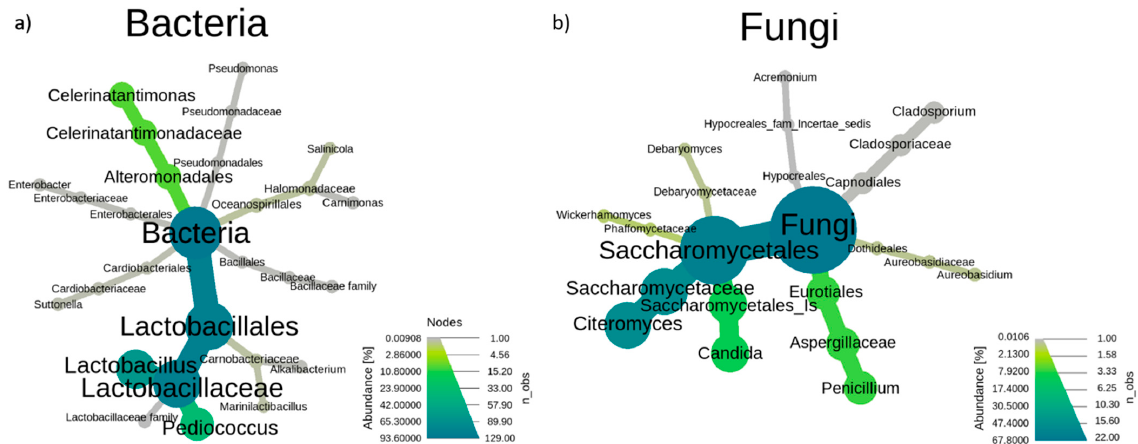
Figure 2. Heat tree from order to genus level obtained by 16 S ( a ) and internal transcribed spacer (ITS) region ( b ) metataxonomic analysis using the total of samples ( n = 15 for bacteria and n = 14 for fungi). Samples that failed quality control ( n = 3) were removed from the study. The colour and size of the branch are indicative of the abundance of sequences (%). Data were generated by grouping all sampling times. Table 1. Global alpha diversity indexes for bacteria (16S) and fungi (ITS) populations obtained from traditional packed Aloreña de M á laga table olives. Data are expressed as a mean ± the standard olive ecosystem (brine and fruit). For bacteria of fungi populations, no significant differences were noticed between sampling times or olive